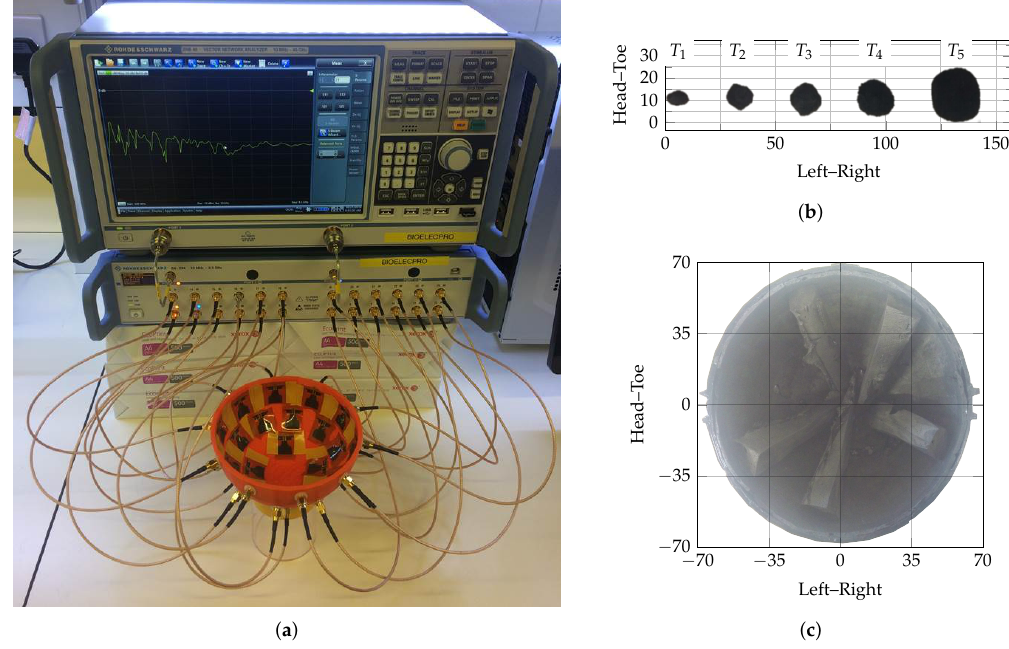
Figure 2. The acquisition system, example phantom and targets are shown here. ( a ) shows the 2-port VNA connected to the 24-port switching matrix. The antennas are shown housed in the 3D printed radome; ( b ) shows the five spherical and smooth tumour models used for evaluation of the FQMs; ( c ) shows the interior of the phantom with 10% glandular content. Three other similar phantoms with 0%, 20% and 30% glandular content were used in this study. All dimensions are in mm. Modular polyurethane breast phantoms and tumour models were fabricated according to